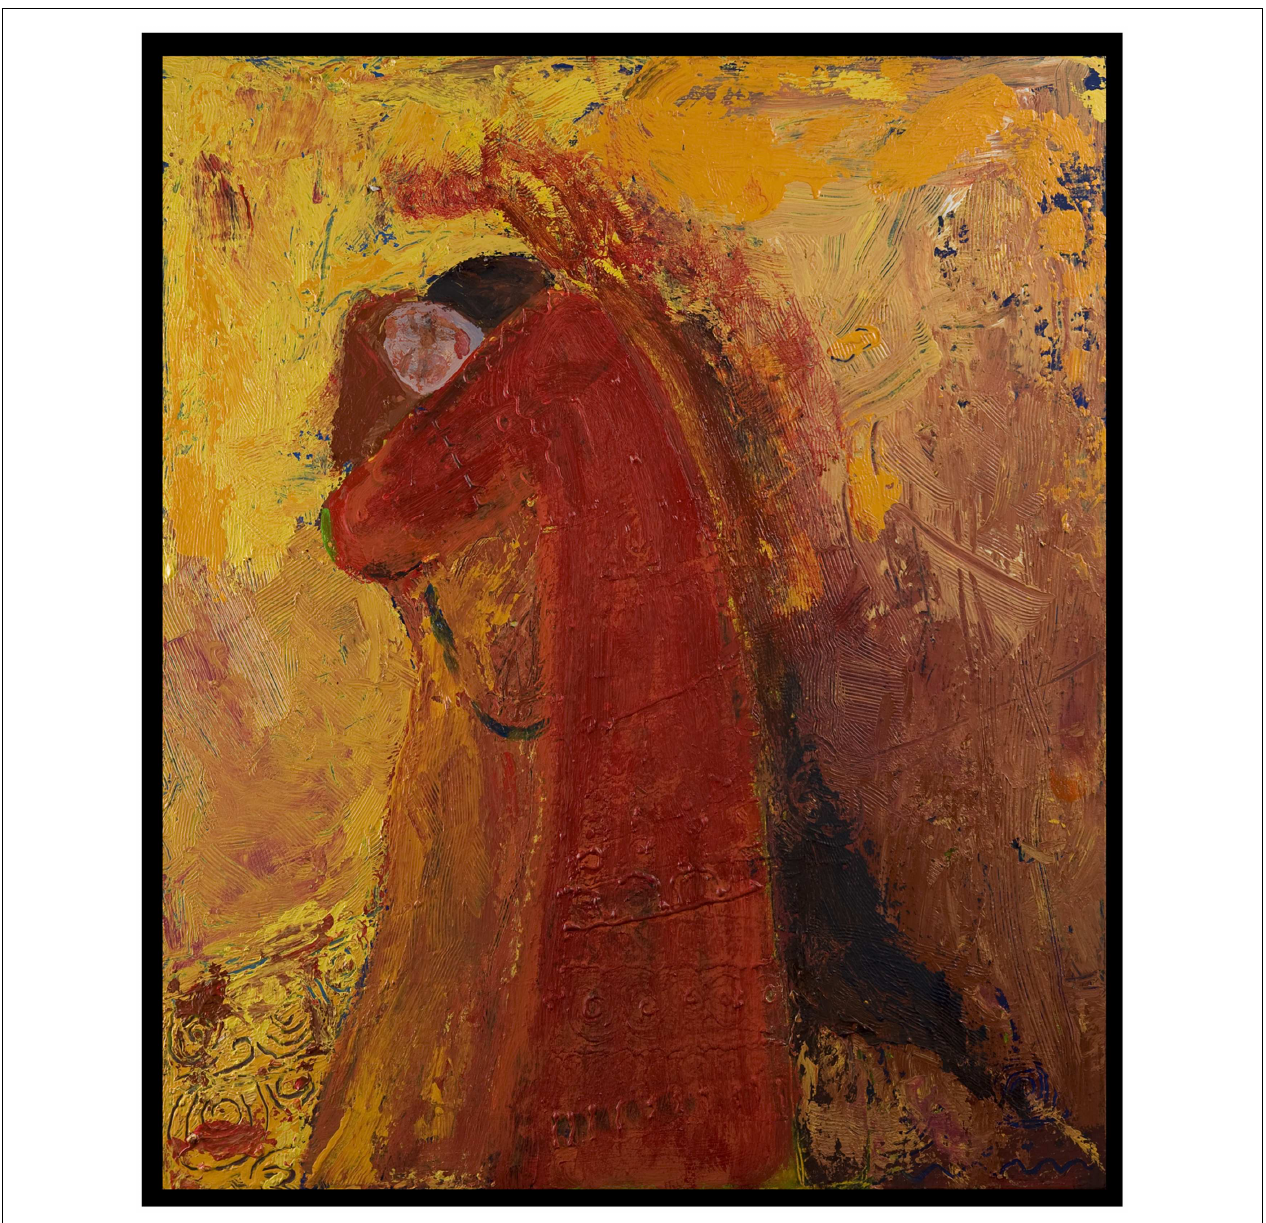
FIGURE 2 |Addictive period . Painting of romantic relationships illustrating the change in content and